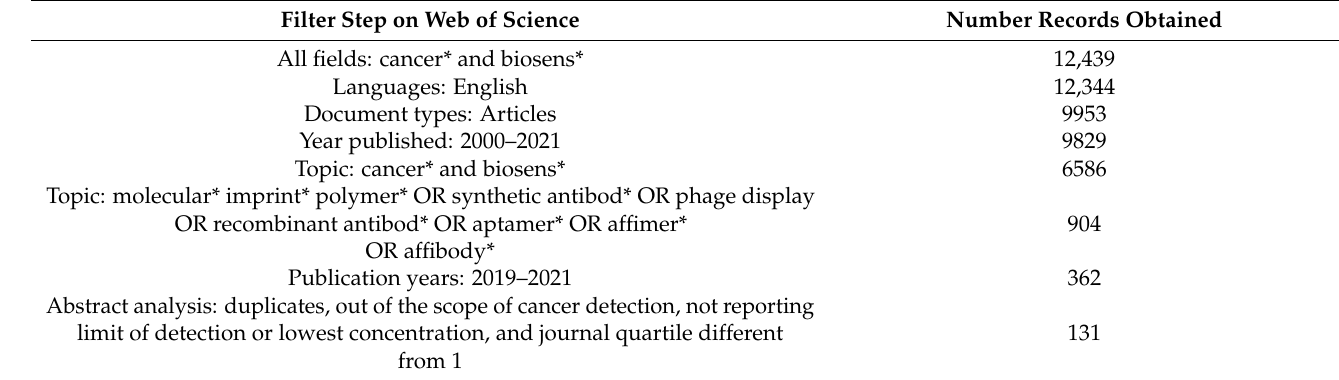
Table 1. Search methodology used in Web of Science (up to 10 December 2021).